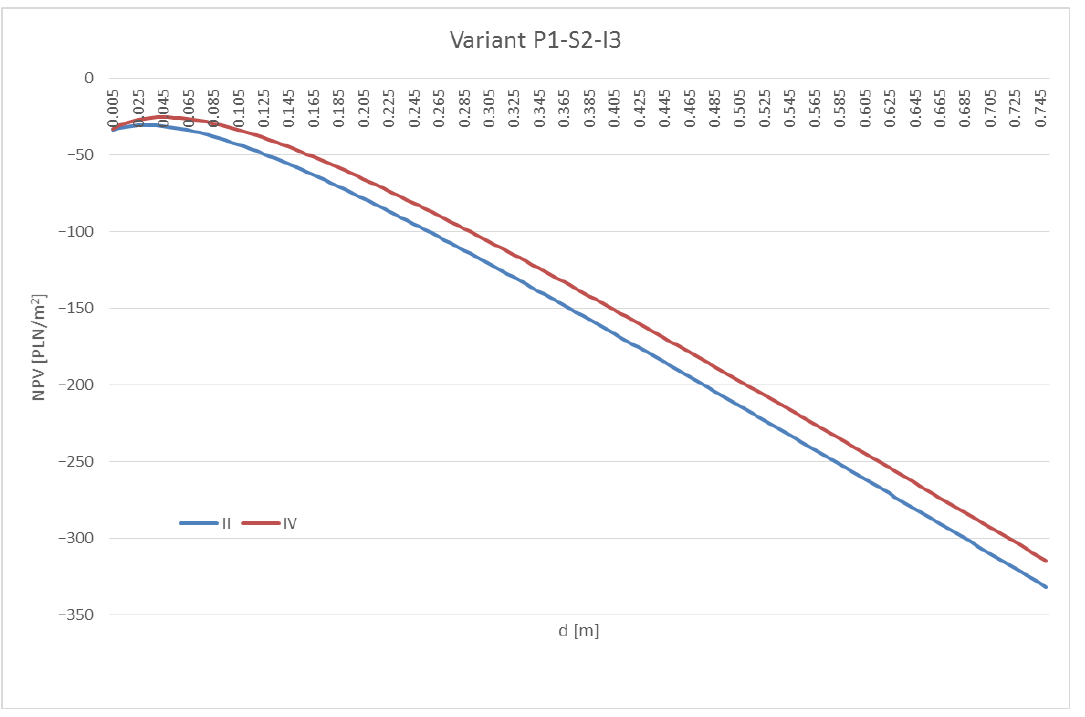
Figure 4. NPV values depending on the thickness of thermal insulation for variant P1-S2-I3 in zones II and IV.